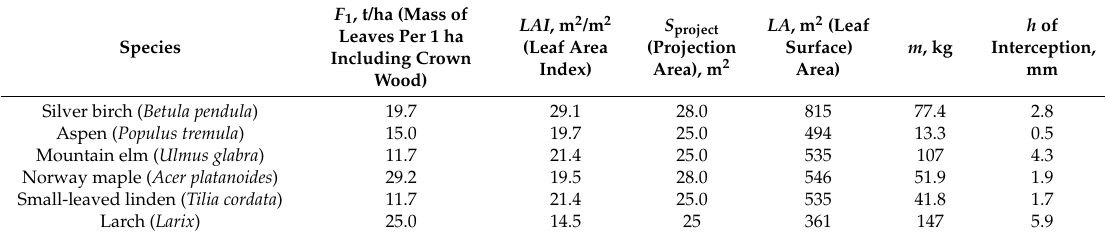
F 1 , t/ha (Mass of S project h of LAI , m 2 /m 2 LA , m 2 (Leaf Leaves Per 1 ha m , kg Interception, (Projection Surface) (Leaf Area Including Crown mm Area), m 2 Area) Index) Wood)